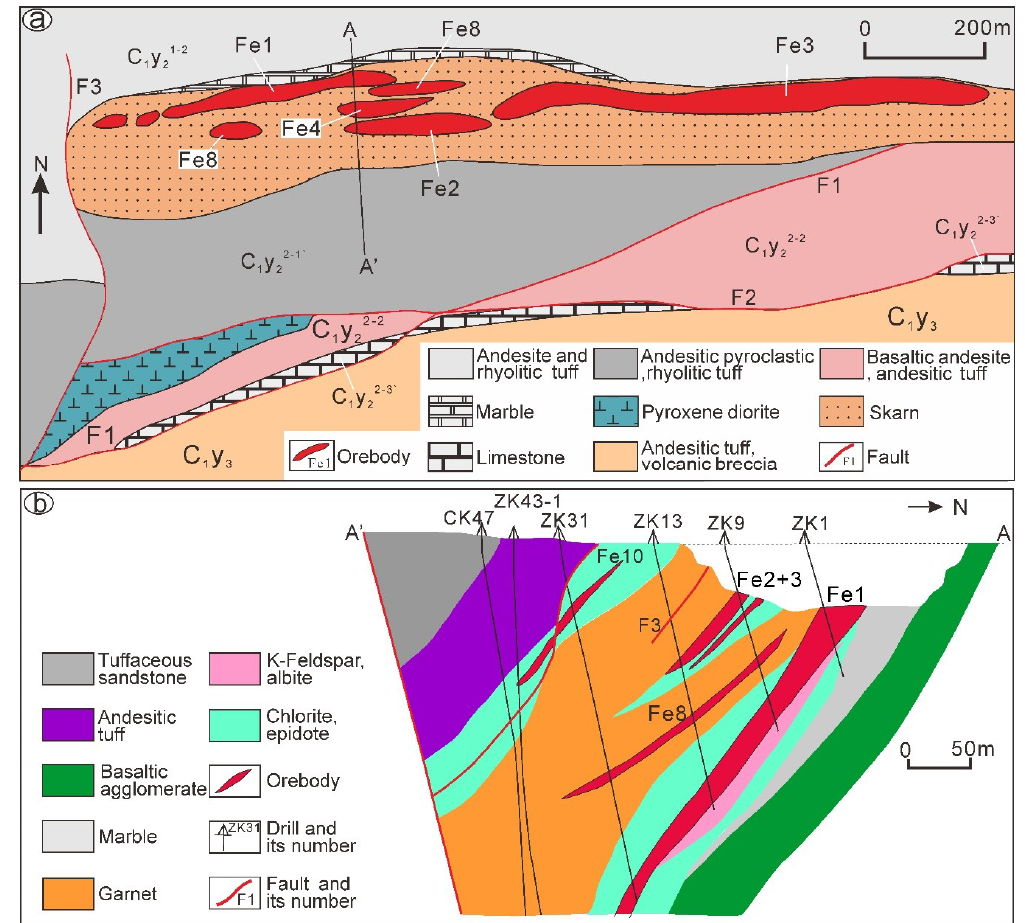
Figure 2. Geological map ( a ) and geological section ( b ) of the Yamansu iron deposit (modified from [23]).